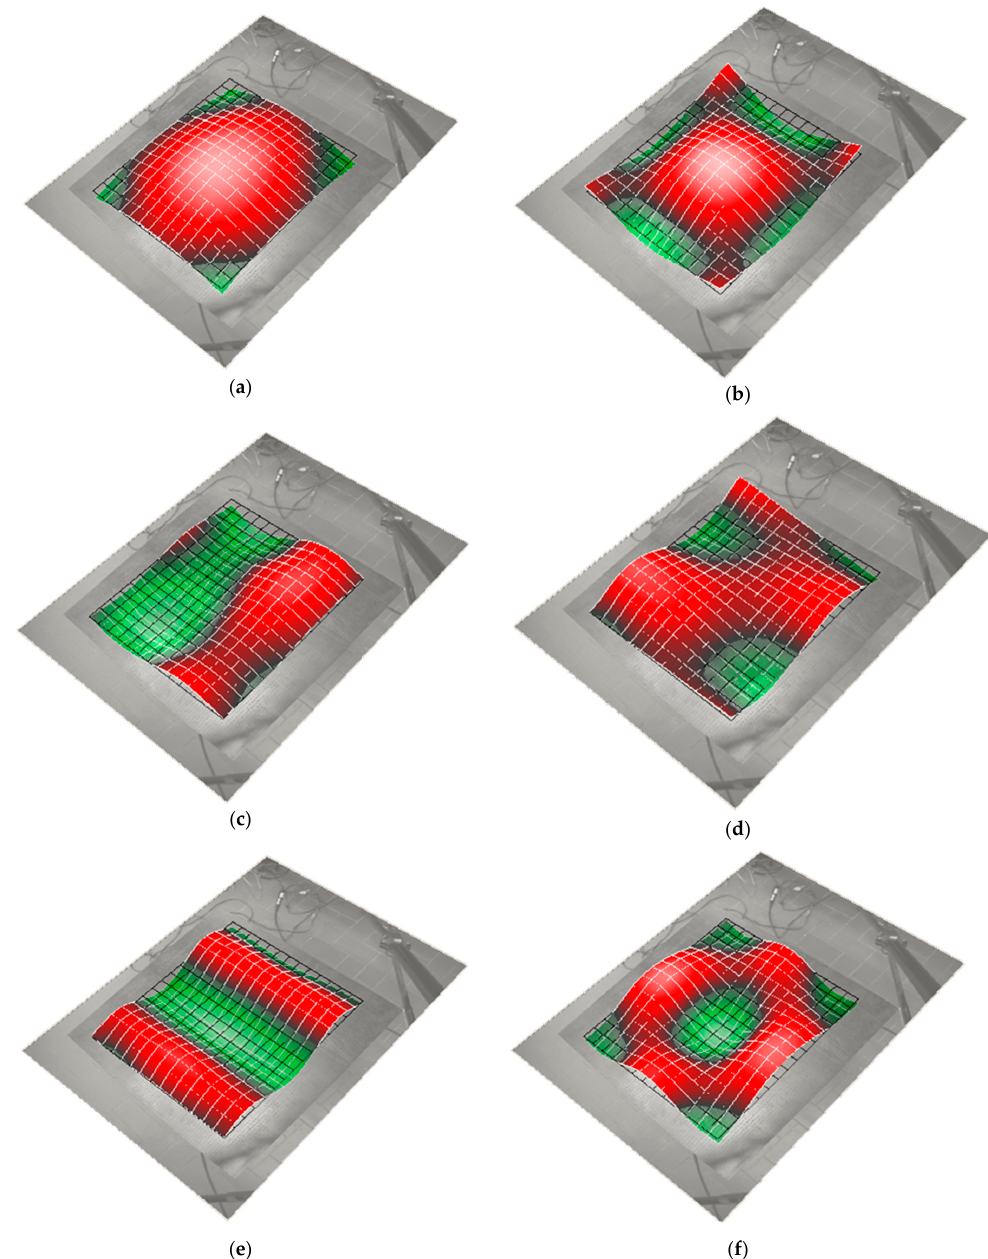
Figure 16. Operating deflection shapes: ( a ) tympanum mode, f = 80 Hz; ( b ) first symmetric bending mode, f = 150 Hz; ( c ) first anti-symmetric bending mode, f = 213 Hz; ( d ) second symmetric bending mode, f = 228 Hz; ( e ) third symmetric bending mode, f = 410 Hz; ( f ) fourth symmetric bending mode, f = 465 Hz.